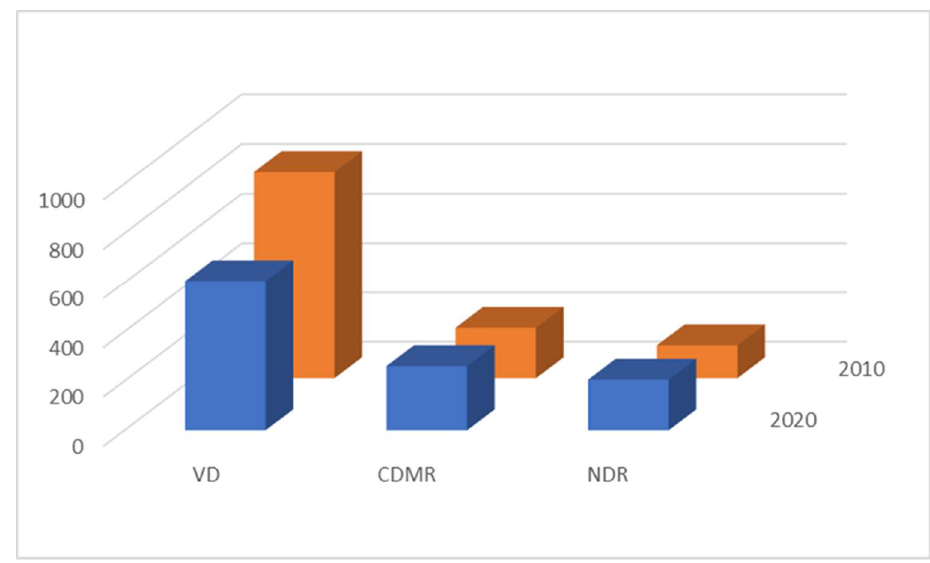
Figure 2. Structure of the preferences. VD–vaginal delivery, CDMR–cesarean delivery on maternal request, NDR–non-decided respondents.